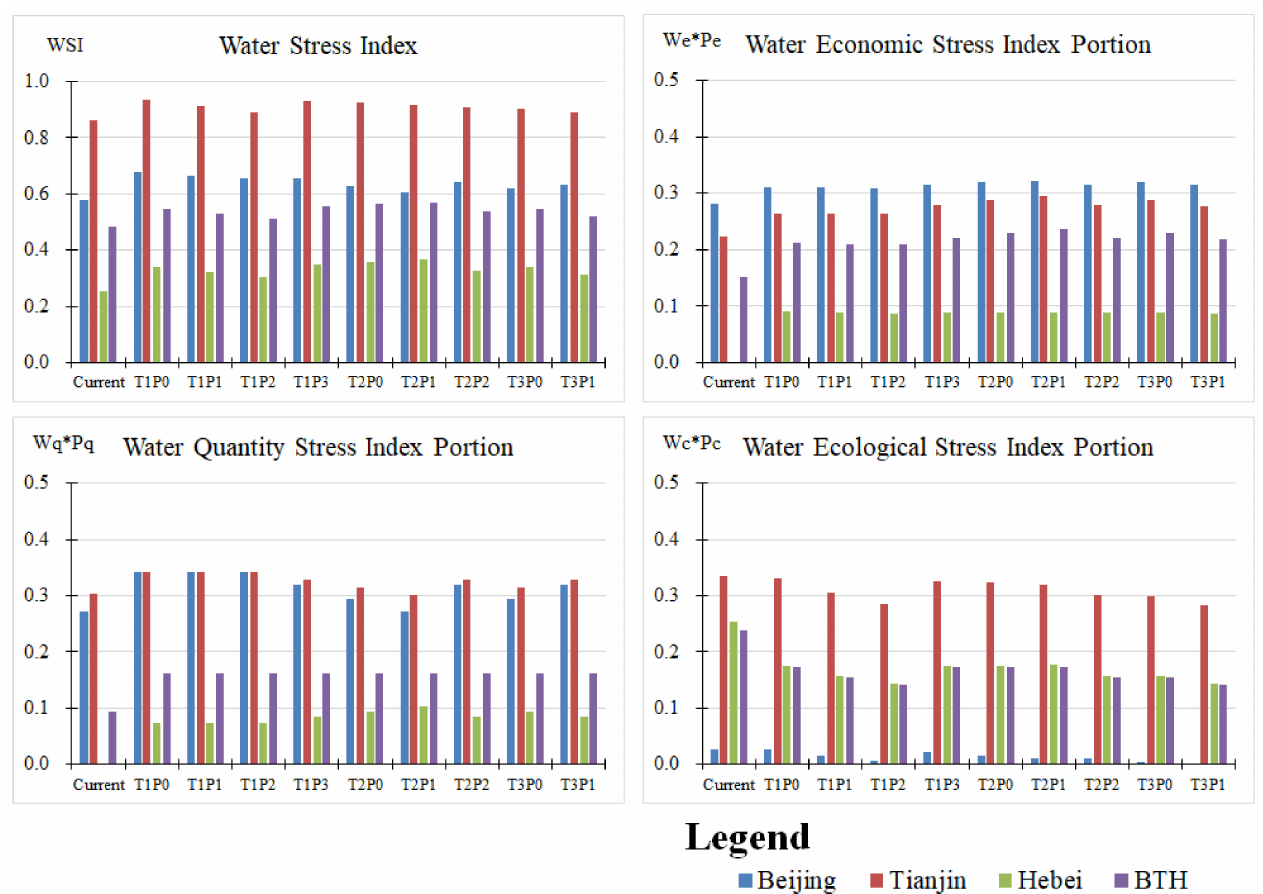
Figure 6. Water stress index and its portion in different